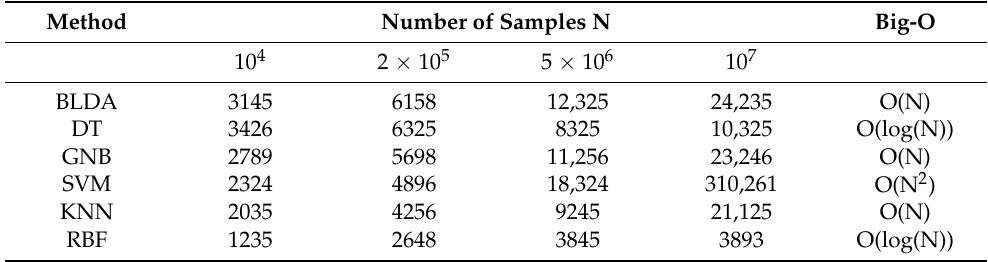
Table 5. Complexity of the classification algorithms obtained for the Big-O